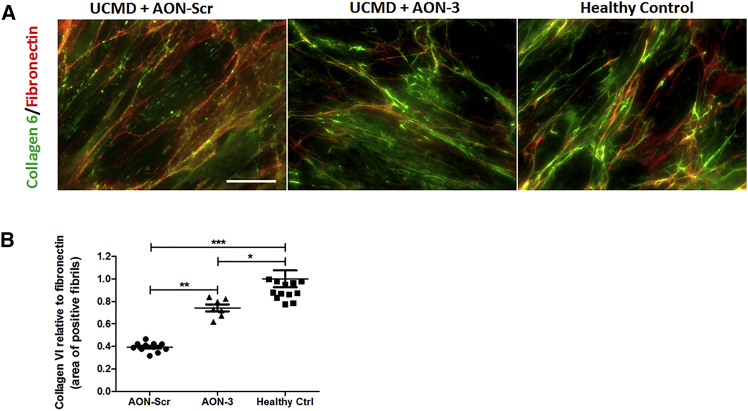
Gapmer AON Increased ECM Deposition of Collagen VI in Co-staining with Fibronectin in Fibroblast(A) Double immunostaining of collagen 6 (green) and fibronectin (red) was performed in a patient’s unpermeabilized fibroblasts treated with scrambled AON (UCMD+AON-Scr) and AON-3 (UCMD+AON-3) and compared with staining in fibroblasts from a healthy control. Scale bar, 30 μm. (B) Semiquantification of the fluorescence signals from collagen 6, relative to the signals from fibronectin, was performed using ImageJ software. Three to four images were captured from each coverslip, and the experiment was performed in triplicate (*p < 0.05; **p < 0.01; ***p < 0.001; n = 9–12 images/group). Data are presented as mean ± SEM.